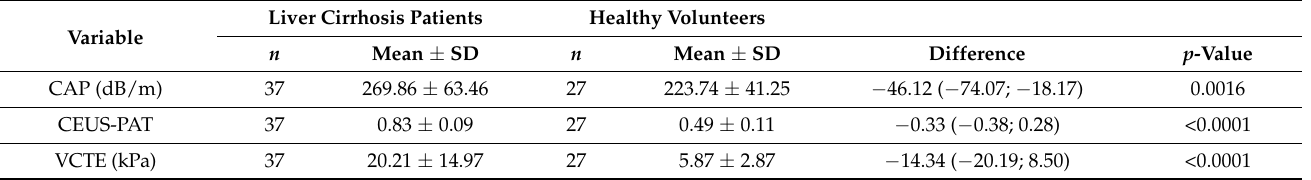
Table 2. Comparison of the CEUS-PAT and elastography measurements between the two groups.